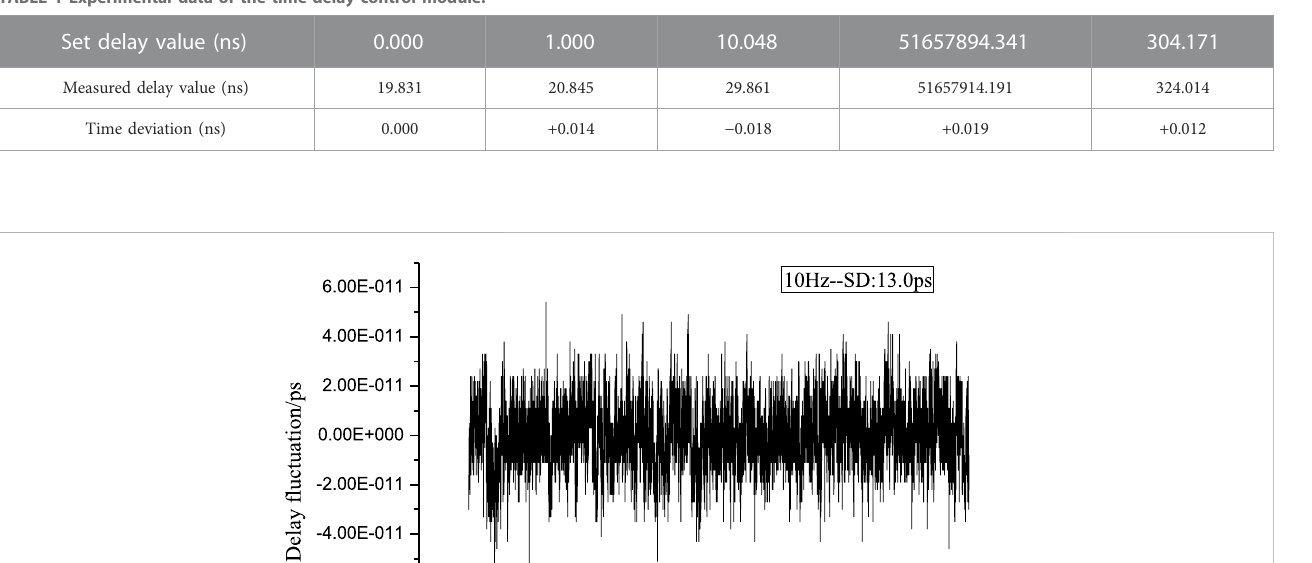
TABLE 1 Experimental data of the time-delay control module.